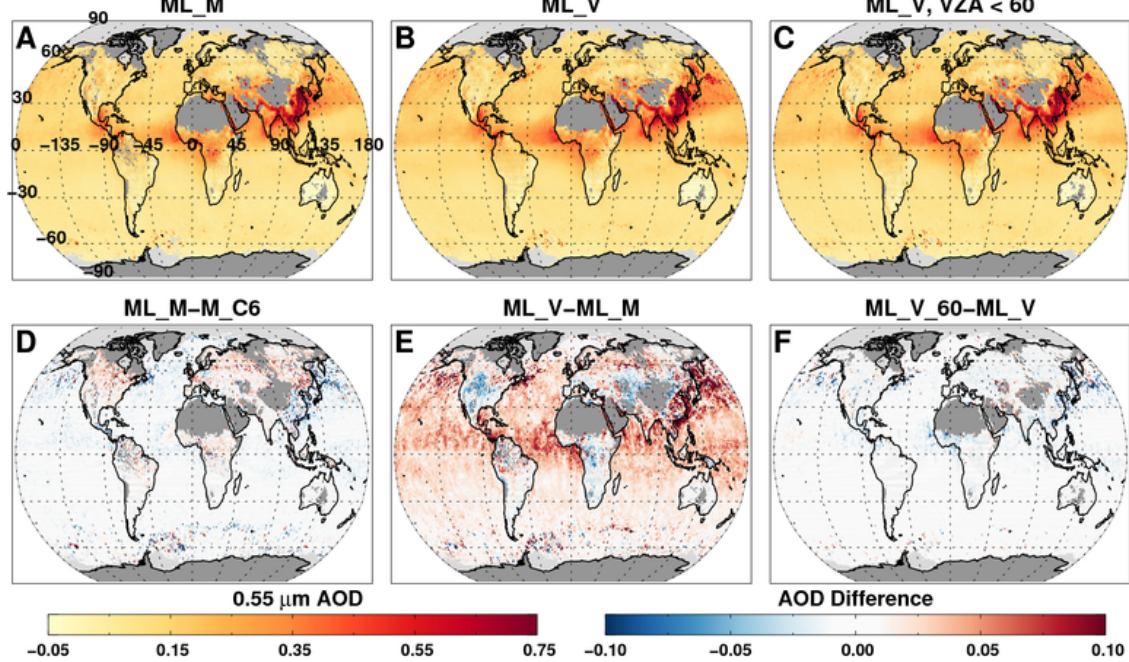
Figure 9. Spring 2013 (March–April–May) maps (1 ◦ × 1 ◦ ) of QA-filtered mean AOD, retrieved from the MODIS-like algorithm on MODIS (a) and VIIRS (b) IFF data sets. (c) is the seasonal plot for VIIRS but subsetted to approximate MODIS coverage (view zenith angle < 60 ◦ ). (d) is the difference between the ML on MODIS and the MODIS C6 product (Fig. 2a), whereas (e) is the difference between the two MODIS-like data sets (b) – (a) . Finally (f) shows negligible difference between seasonal means derived from the reduced swath and entire VIIRS swath (c) – (b) . See Fig.